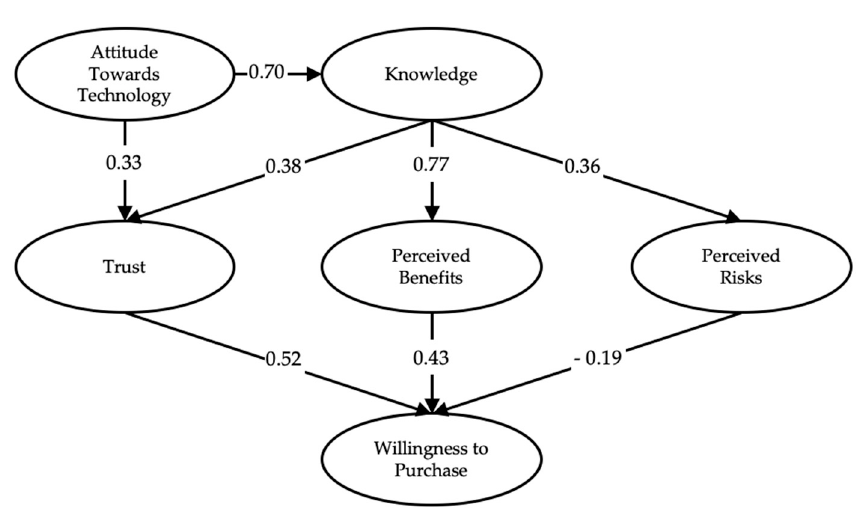
Figure 3. Standardized estimates for the edited model (Second Survey). Table 6. Model Fit Index.